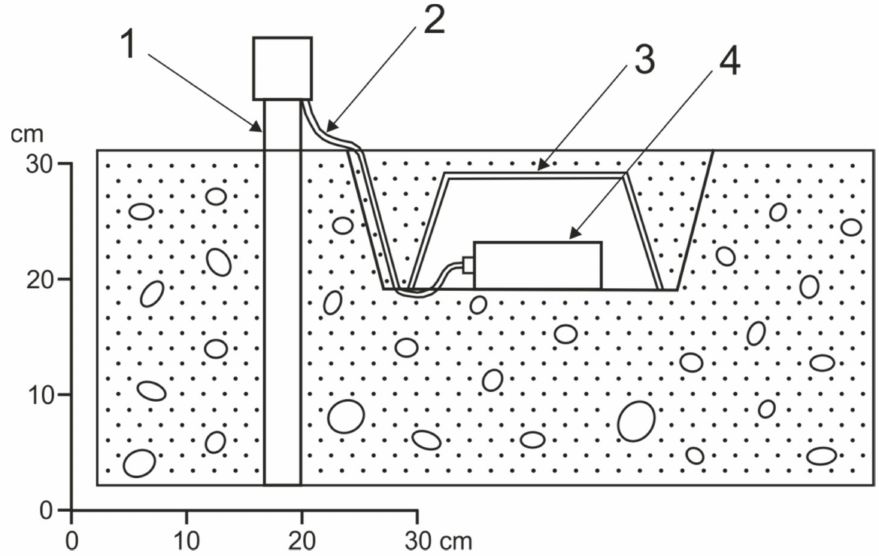
Figure 3. Schematic of data logger protection against flooding at the experimental site. 1-protective tube; 2-sensor cable; 3-metallic cap;